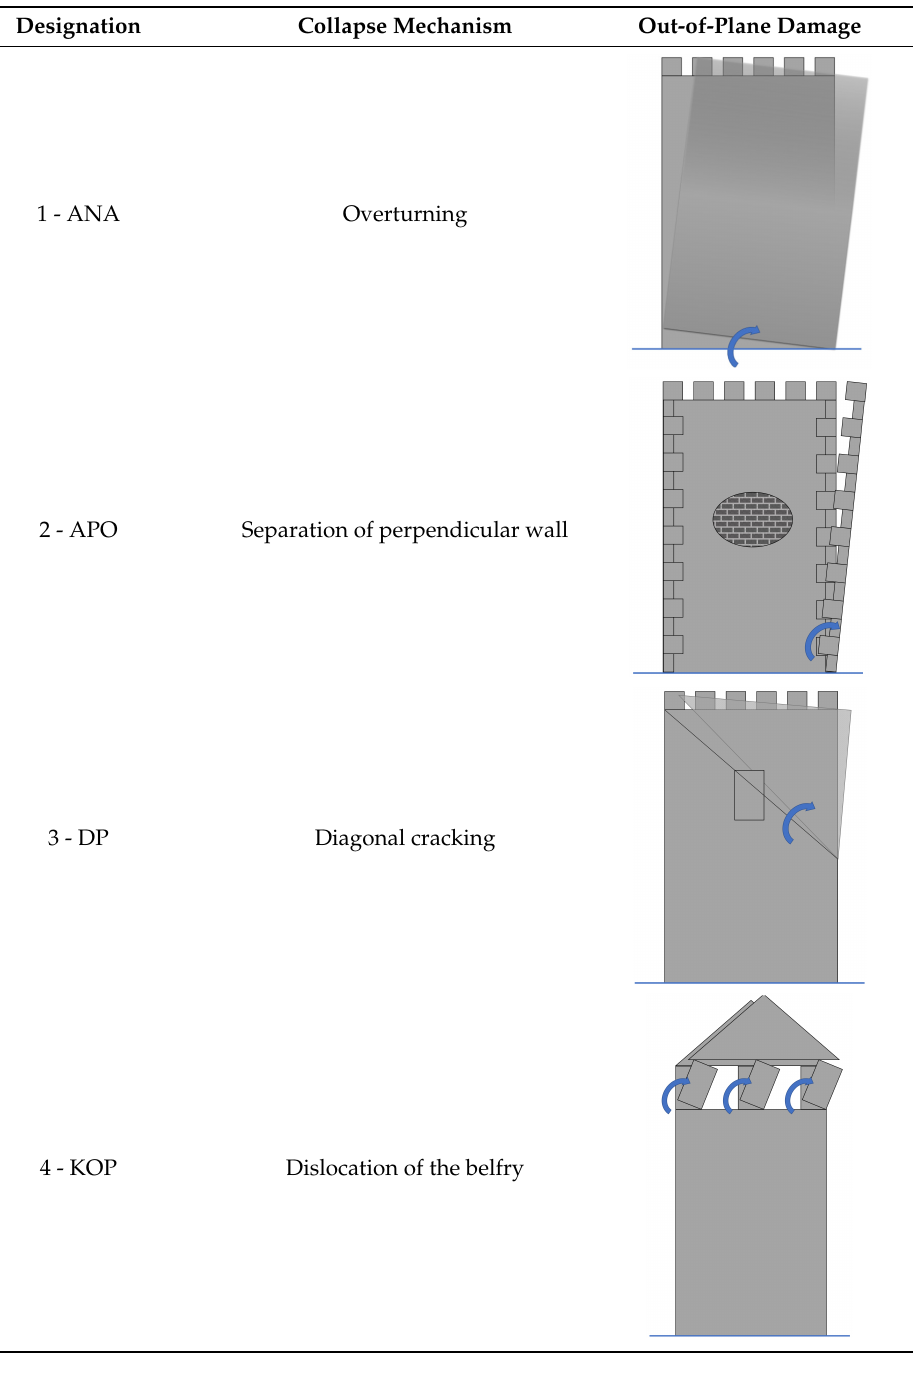
Table 5. Out-of-plane collapse